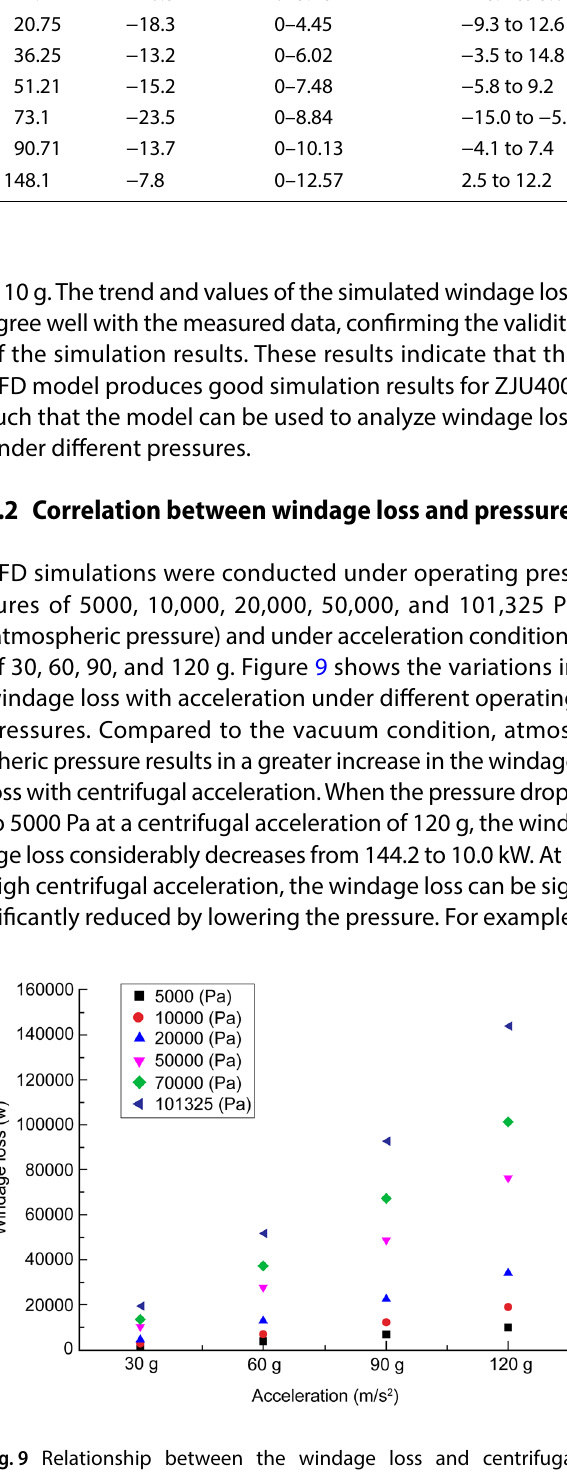
Centrifugal acceleration (m2/s)